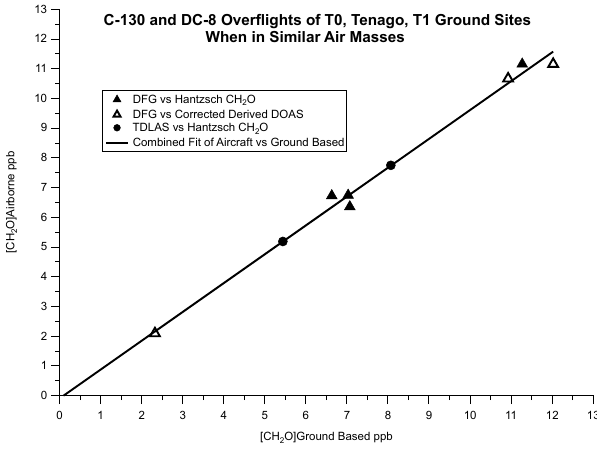
Fig. 2. Comparisons between aircraft measurements of CH 2 O from the C-130 and DC-8 during overflights with ground sites when co- incident measurements were acquired by a Hantzsch system and/or a DOAS system. The DOAS CH 2 O mixing ratios were corrected by the ratio of the DOAS derived NO 2 to C-130 NO 2 measurements as discussed in the text. The DC-8 CH 2 O measurements were acquired with the TDLAS system while the C-130 aircraft acquired DFG CH 2 O measurements. A linear regression of the 9 points yields a slope of 0.971 ± 0.03, an intercept of − 0.09 ± 0.3ppbv and an r 2 of 0.992.